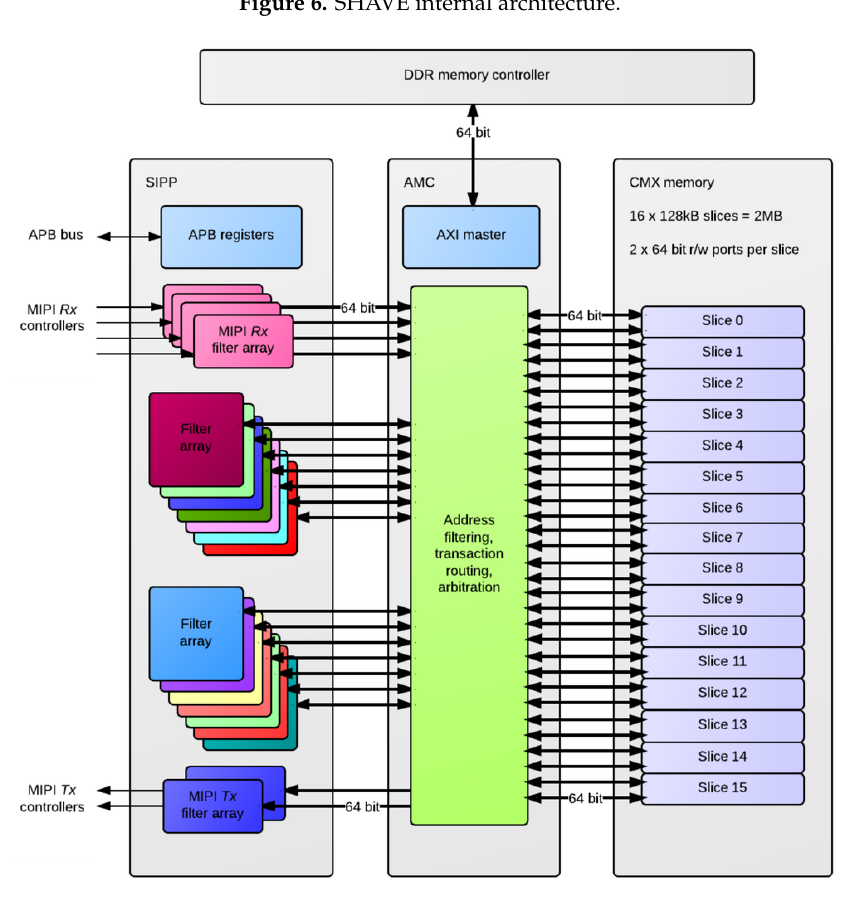
Figure 7. Block diagram of SIPP accelerator, AMC and connections to CMX